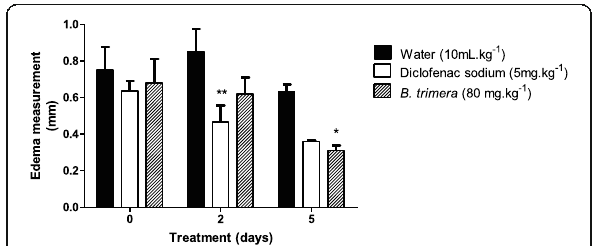
Myeloperoxidase measurement in the subcutaneous tissue of the mice after chronic inflammation In order to investigate the contribution of the neutro- phils in the inflammatory response that was induced by FCA, the researchers performed the MPO assay, as described in Material and Methods. The results did not show any significant changes in the myeloperoxi- dase activity from the subcutaneous tissue of the mice, after the treatment with B. trimera (1.84 ± 0.28